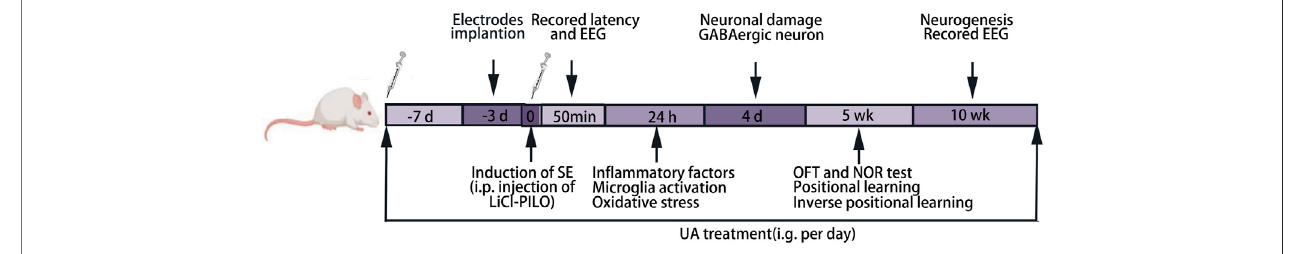
FIGURE 1 | Experimental timeline. LiCl-PILO: lithium-pilocarpine; OFT: open- fi eld test; NOR: novel object